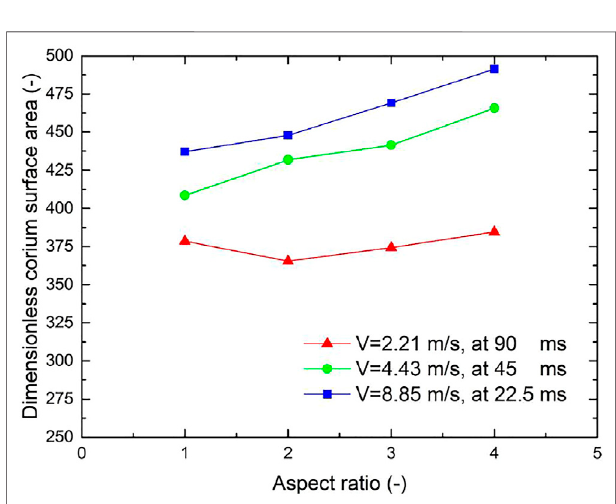
FIGURE 6 | Dimensionless corium surface area vs. aspect ratio at approximately the same penetration depth in the 12 cases.